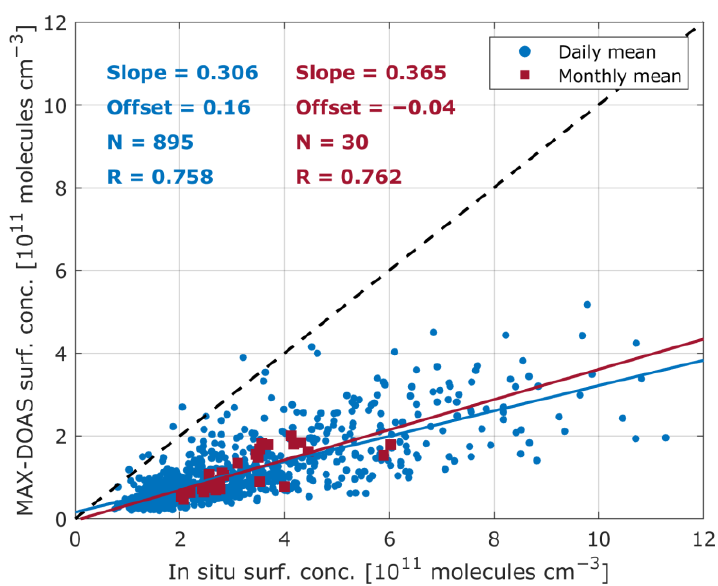
Figure A1. Scatter plot of the daily and monthly mean surface concentrations that were retrieved by the MAX-DOAS and the in situ instruments for the period of study.